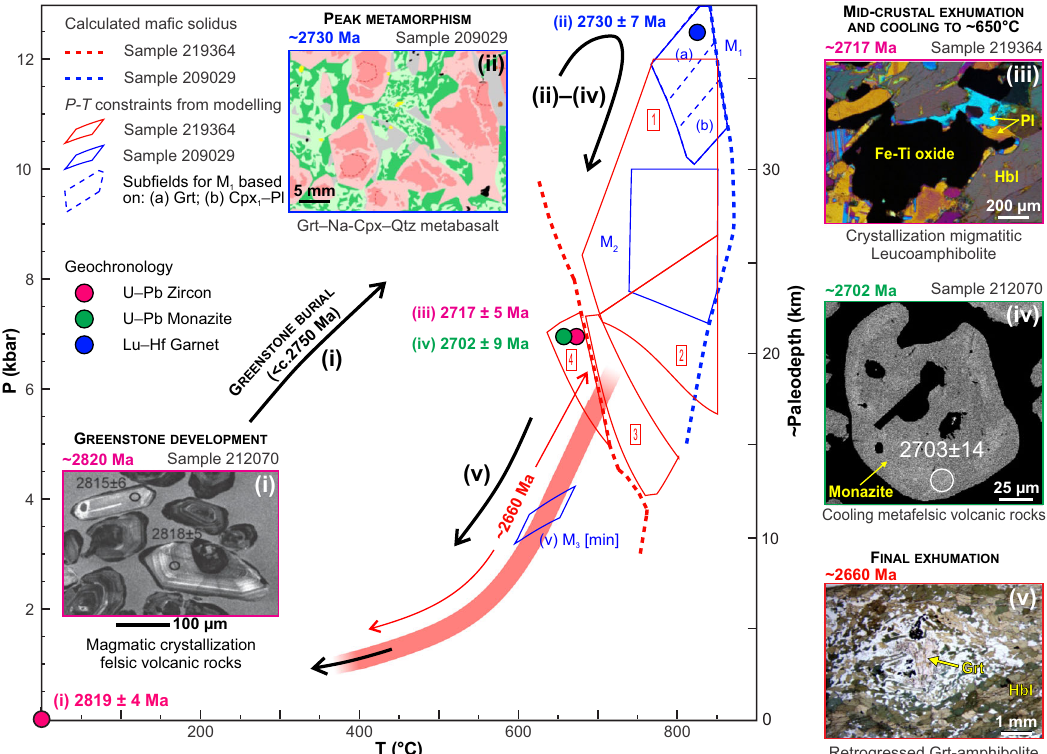
Fig. 7 | Metamorphic evolution of the Waroonga greenstone belt (WGB). Summary of the metamorphic evolution for the WGB, based on phase equilibrium modelling of samples 209029 and 219364. The fi ve insets show the representative microstructuresforeachofthestepsthatweusedtotracethe P – T – t path.(i)Dating of euhedral zircons in sample 212070 de fi ne the formation age of the WGB; (ii)the peakassemblage in amphibolite clinopyroxene – garnet – quartz is well preservedin